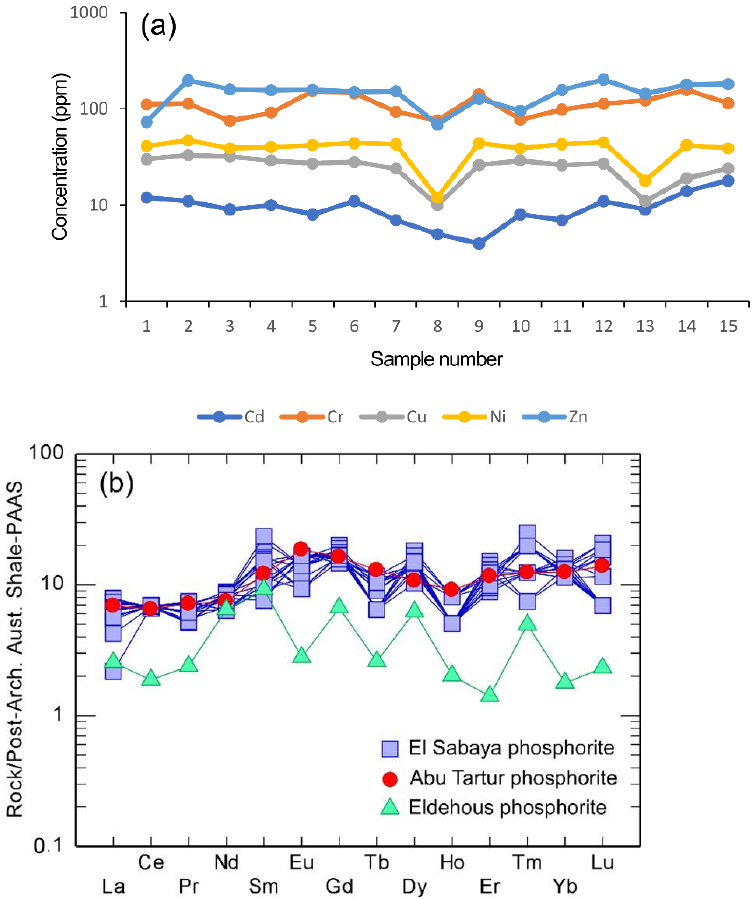
Figure 5. ( a ) Trace elements distribution curves of the examined phosphorite samples; and ( b ) REEs- normalized to Post Archean Australian Shale (PASS) [27] of the examined phosphorite and compared with the average REEs of Abu Tartur phosphorite [25] and Eldehous phosphorite